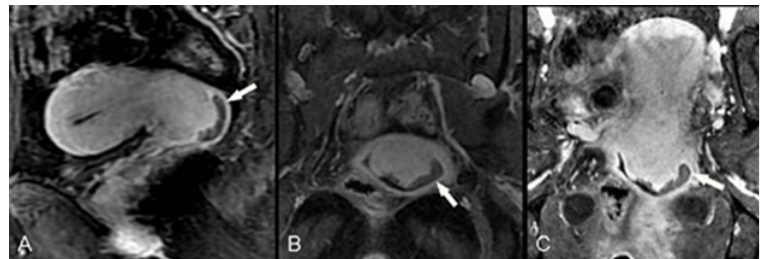
Fig 4. F55, poorly differentiated squamous cell carcinoma (stage IIA1). Directly acquired contrast- enhanced sagittal image (A) shows a tumor in the posterior cervical lip invading the vaginal fornix (arrow), with relative lower signal compared with the surrounding cervical stroma. Directly acquired contrast- enhanced coronal image (B) fails to show the entire uterus and the relationship between the lesion and vagina due to uterine anteversion. CPR from isotropic sequence (C) reconstructs the uterine and vaginal lesions in the same slice so that the relationship between the lesion and the vagina is more clearly displayed (arrow).